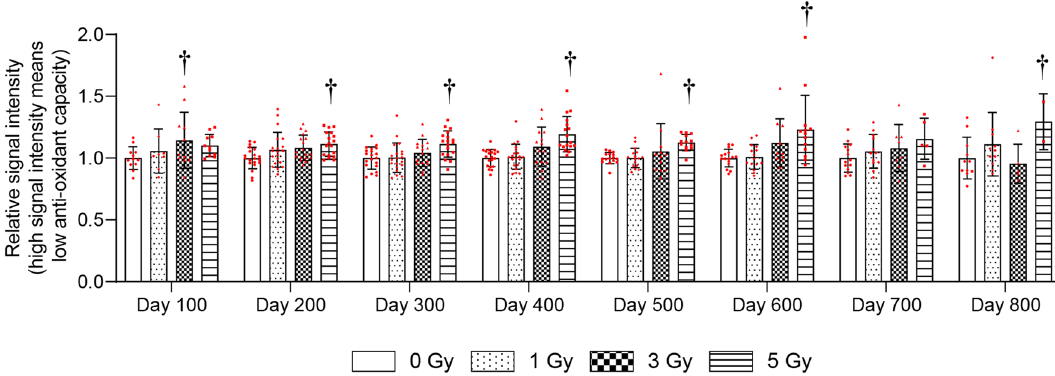
Figure 1. Change in antioxidant capacity of whole blood more than 100 days after total body irradiation (TBI). Whole blood antioxidant capacity was measured using i-STrap. Antioxidant capacity is inversely correlated with signal intensity. Bars indicate the means, error bars indicate the SDs, and red dots indicate individual data points. Two-way ANOVA and the post hoc Dunnett’s test were used to analyze significant differences with the 0-Gy group. † Indicates P <